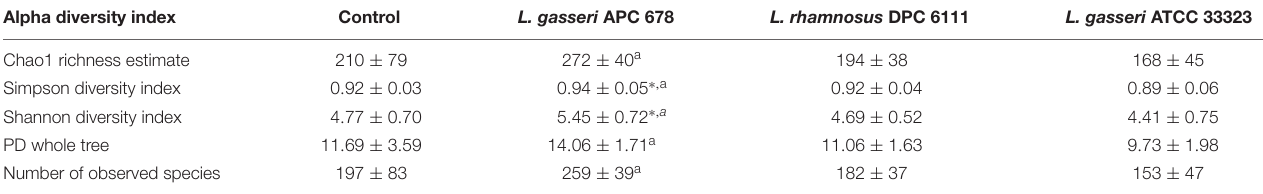
TABLE 3 | Alpha diversity indices for sequencing coverage and microbiota diversity from cecum samples at Day 7 from control and test mice.